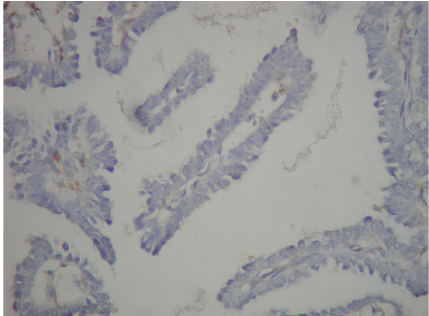
Figure 5: Immunohistochemical SMA stain showing the absence of myoepithelial cell layer in papillary structures ( × 400).